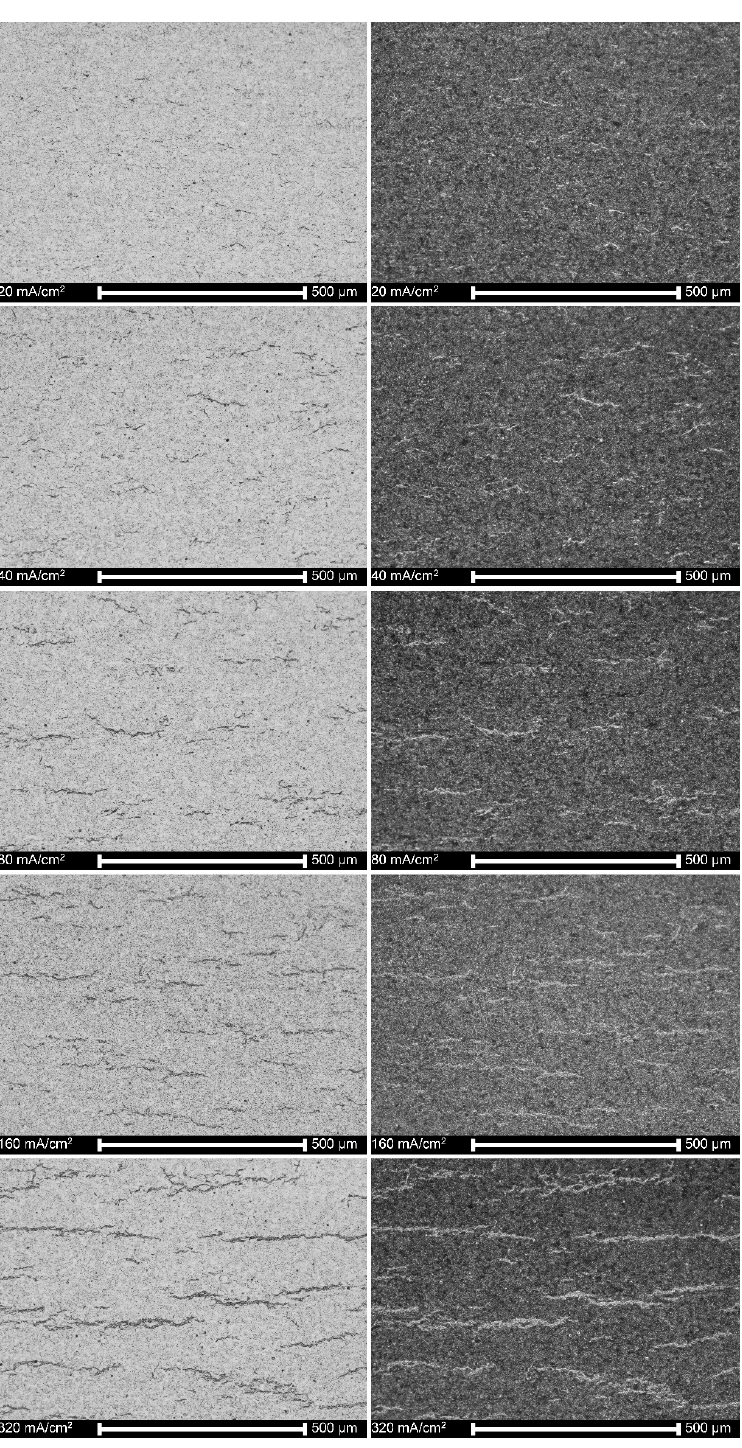
Figure 9. The cross-sections of nonoxidized specimens charged at different cathodic current densities (on left—the light area; on right—the dark area).